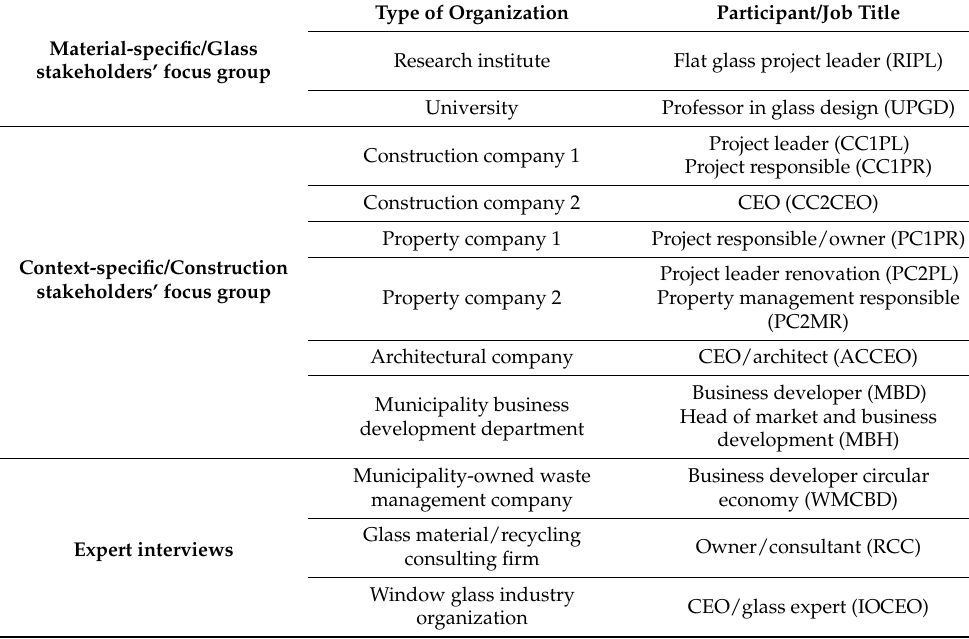
Table 1. Participants in the empirical data collection (abbreviations for